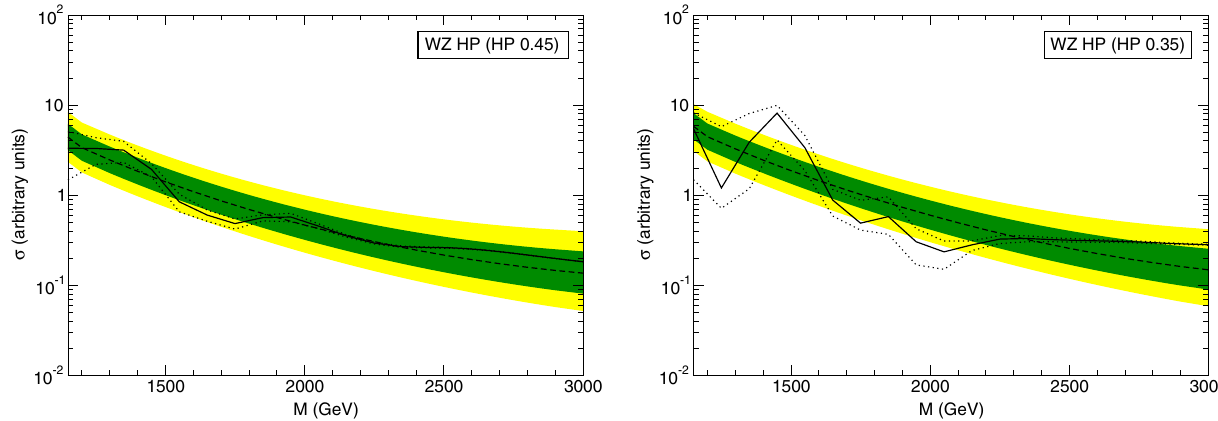
Fig. 16 Upper limits on the cross section of a possible narrow resonance signal, as a function of its mass M , obtained using the background distributions in Fig. 15 after selection as pseudo-data